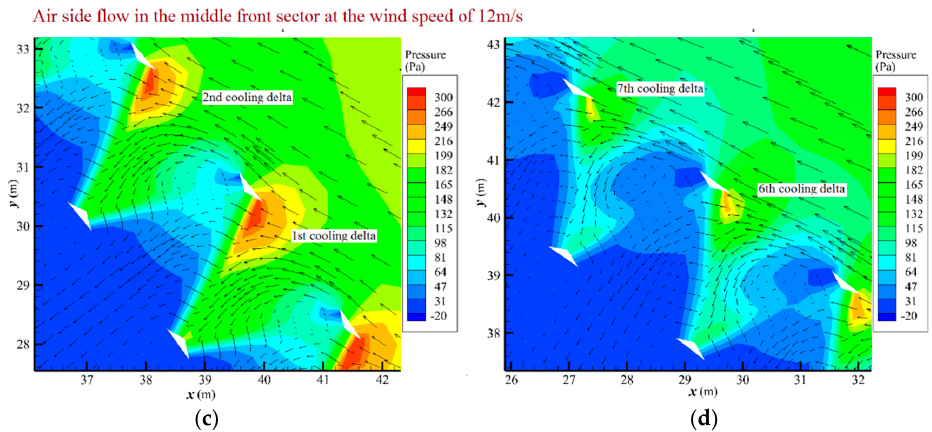
Figure 6. Air flows of representing deltas in frontal and middle front sectors under crosswind of 12 m/s, ( a ) 1st and 2nd delta in frontal section; ( b ) 6th and 7th delta in frontal section; ( c ) 1st and 2nd delta in middle front section; ( d ) 6th and 7th delta in middle front section.